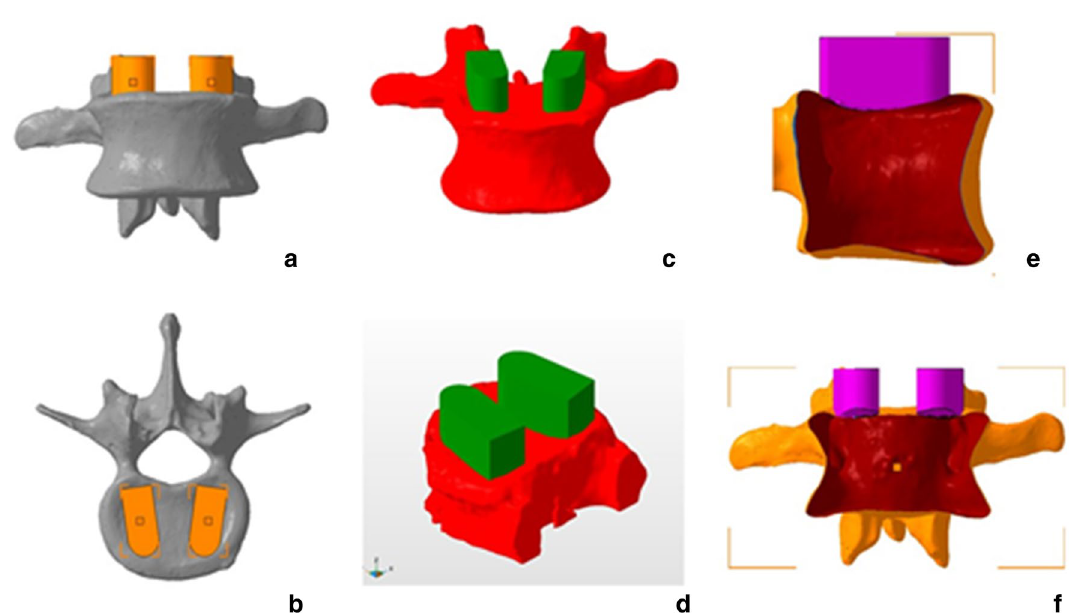
Figure 5. Anterior and superior views of cage planned positions( a,b ), anterior and oblique views of the Boolean operation( c,d ), and lateral and anterior views of the hollow vertebra and the conformational implant post-Boolean operation ( e,f